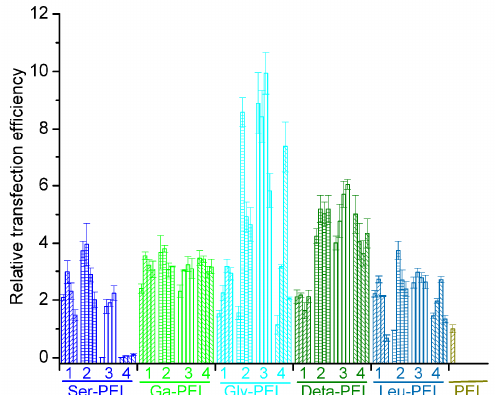
Figure 4. Luciferase gene expression transfected by polyplexes at different weight ratios in Figure 4. comparison with 25 kDa PEI ( w / w = 1.4, N/P = 10) in U-2OS cells in the absence of serum. In each group of columns, the w / w are 2, 3, 4, and 5, consecutively. Data represent mean ± SD ( n = 3).